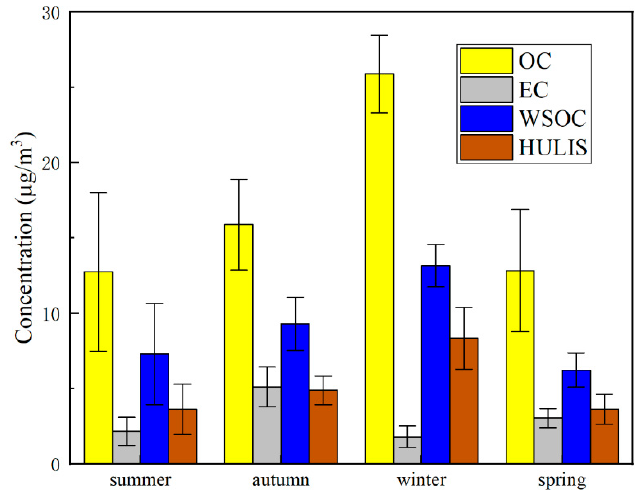
Figure 1. Mean concentrations (seasonal) of OC, EC, WSOC and HULIS in the total suspended particulates in Shanghai.